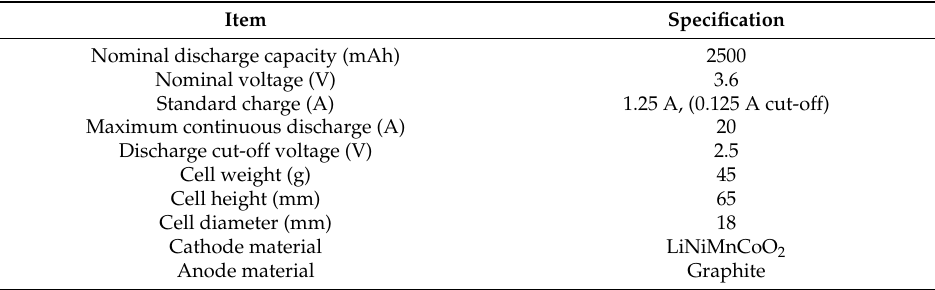
Table 1. Specifications of the test cell (Samsung INR 18650-25R)